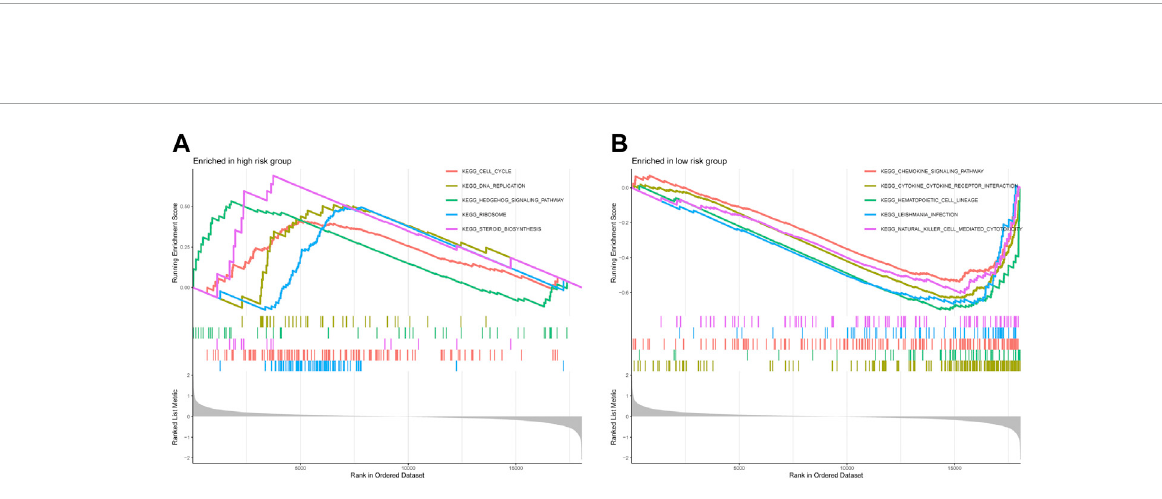
FIGURE 7 The GSEA analysis results between the high-risk group and low-risk group. (A) . Top fi ve enriched pathways in the high-risk group. (B) . Top fi ve enriched pathways in the low-risk